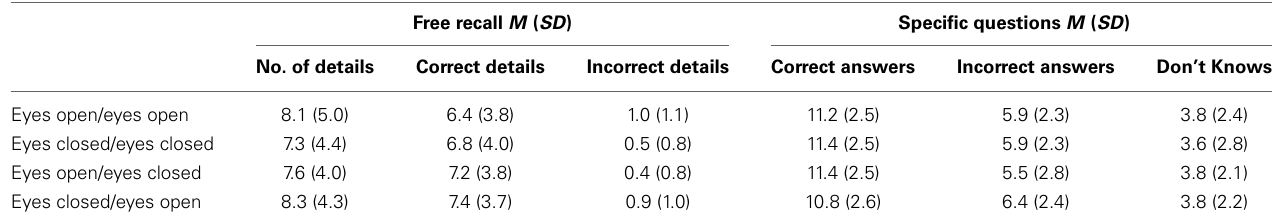
Table 2 | Mean scores for each interview condition in Experiment